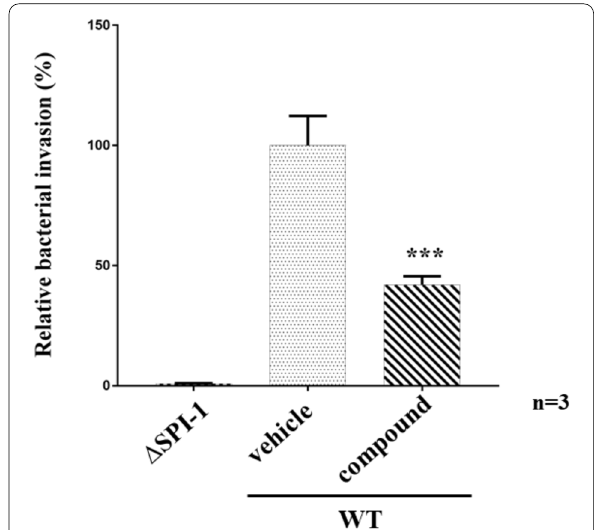
Fig. 3 The small molecule decreased the efficiency of bacterial invasion. The standard deviations from three individual experiments are indicated. Asterisks indicate significantly different ( p <0.05) between wild-type Salmonella treatment with or without compound. The SPI-1-negative strain ( invC::kan R ) was used as control